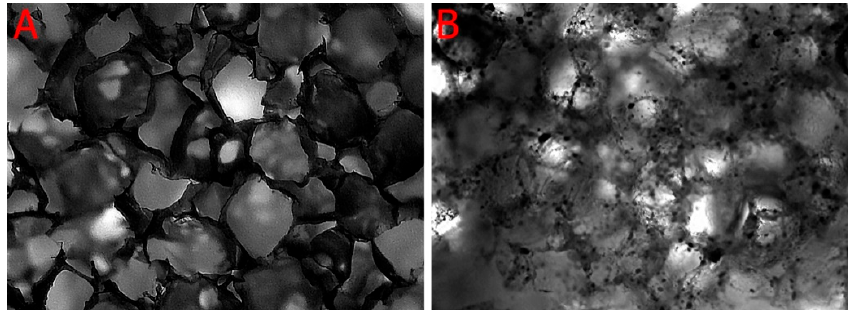
Figure 3. Phase contrast images show that both polylactic acid polymer (PLA) ( A ) and PLA- hydroxyapatite (HA) ( B ) scaffolds are highly porous and interconnected. Images were captured with a 4× objective. Table 2. Porosity analysis among di ff erent locations within the anatomically-shaped sca ff olds. Table 2. Porosity analysis among different locations within the anatomically-shaped scaffolds. Porosity Porosity Analysis